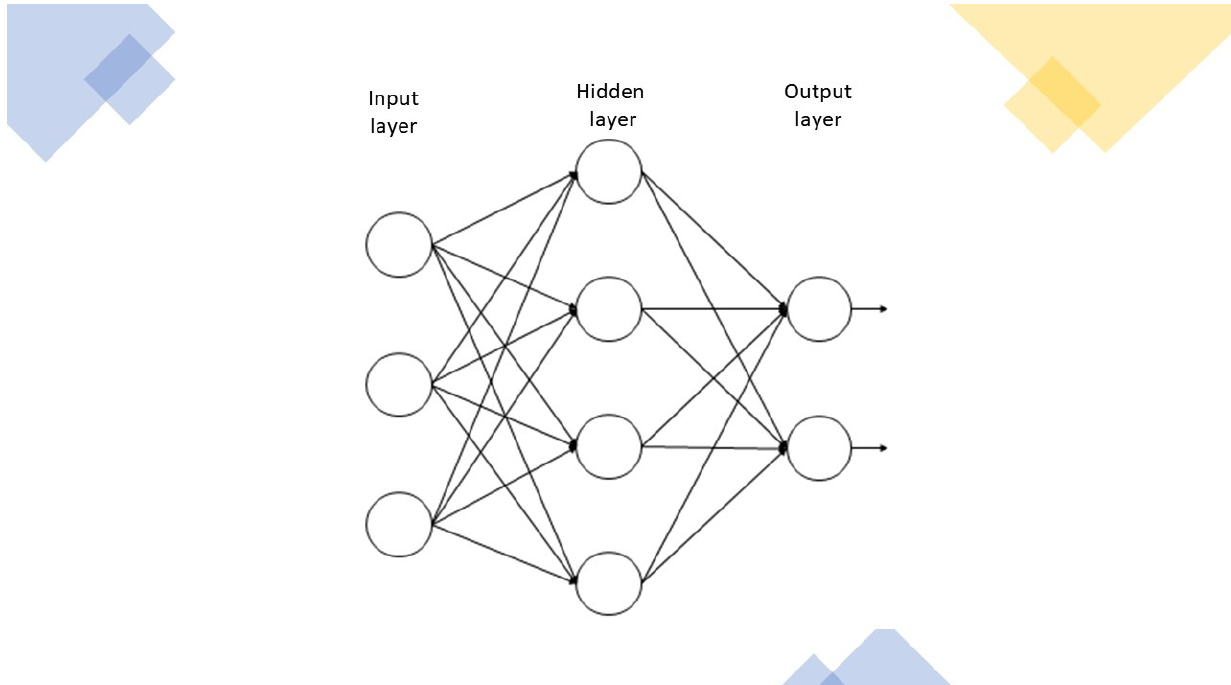
Figure 1. Schematic diagram of an artificial neural network structure with one hidden layer.